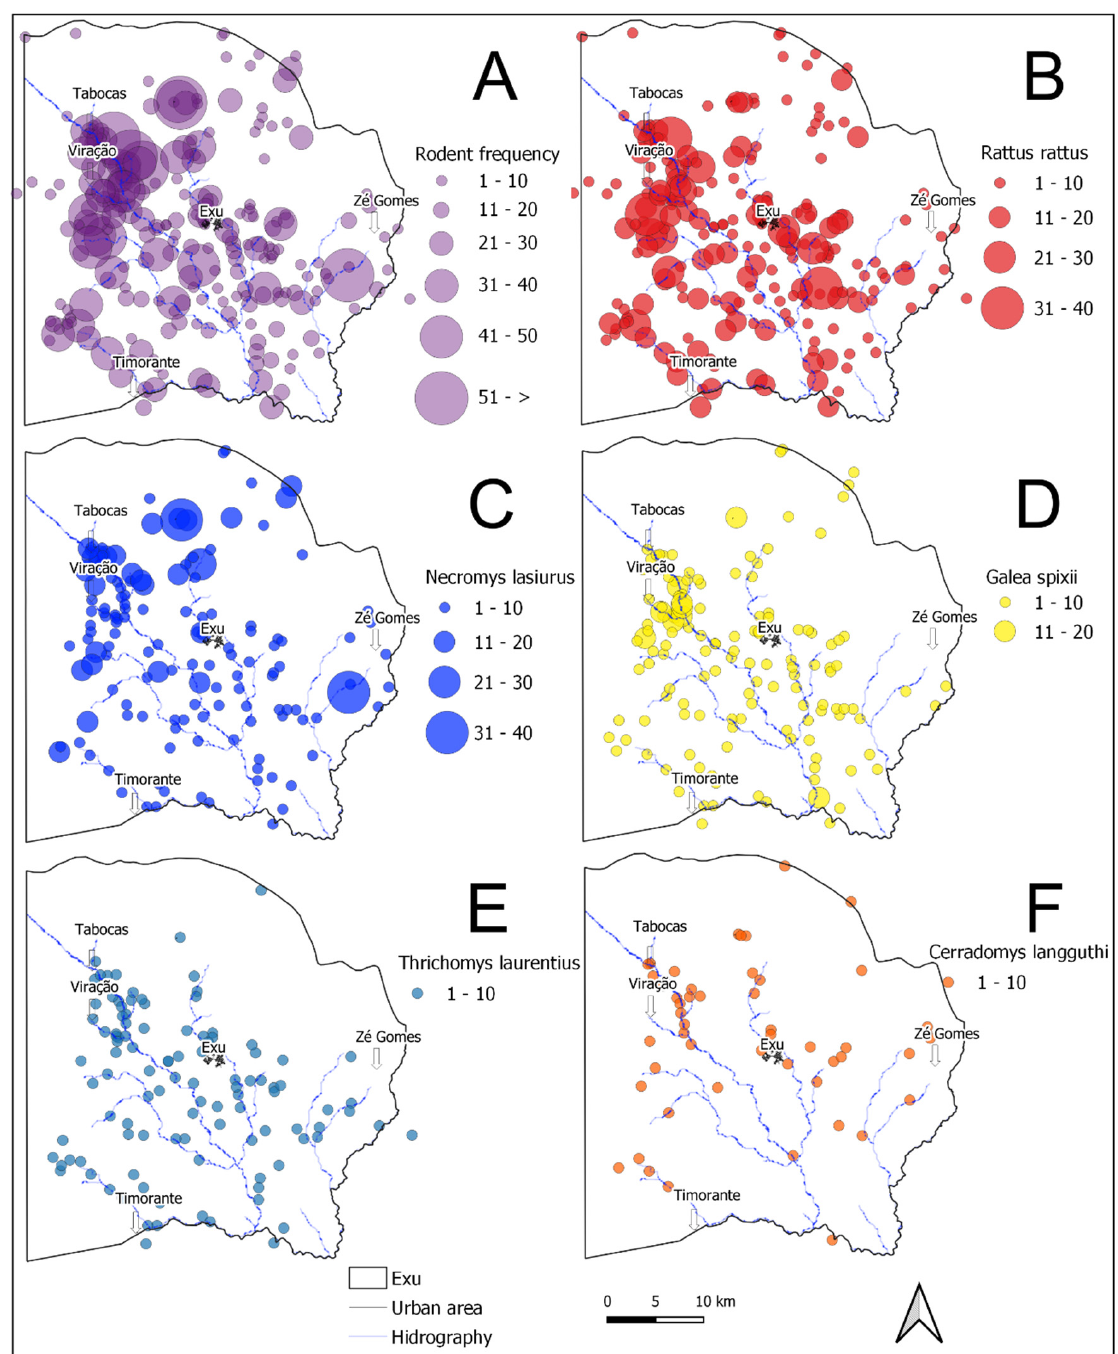
Figure 3. Distribution and abundance maps of the rodent species captured in the localities of Exu, Pernambuco, Brazil, 1996 to 2005. ( A ) Total rodents captured. ( B ) R. rattus . ( C ) N. lasiurus . ( D ) Galea spixii . ( E ) T. laurentius . ( F ) C. langguthi .